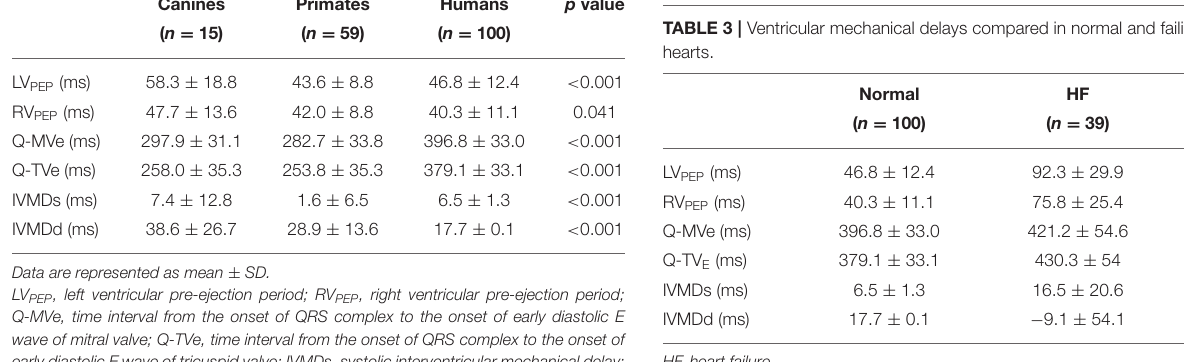
HF, heart failure. Other abbreviations as in legend to Table 2